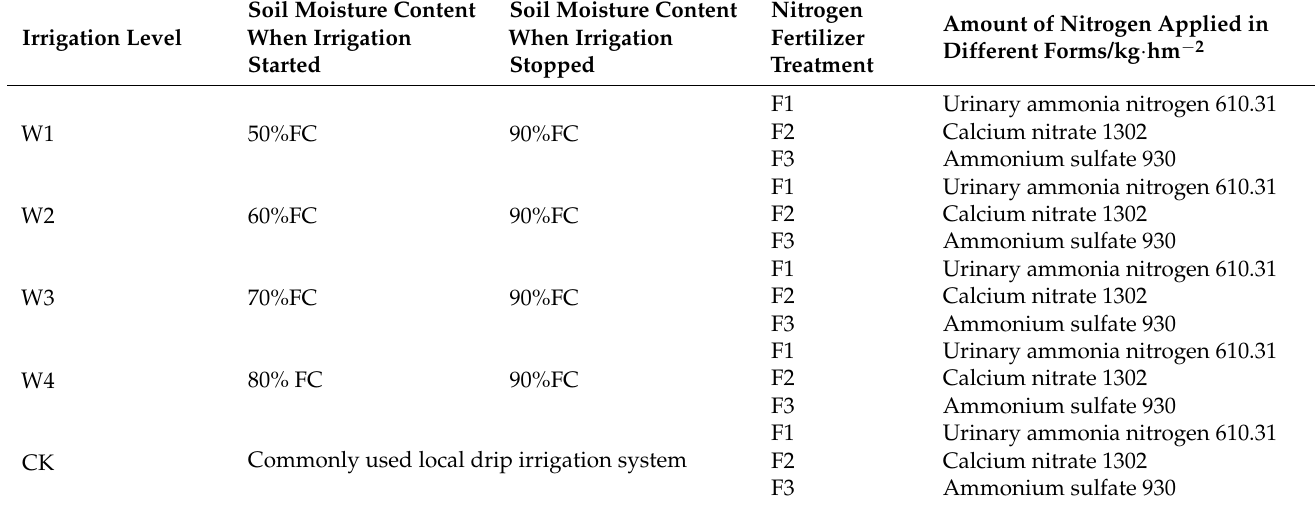
Table 2. Experimental